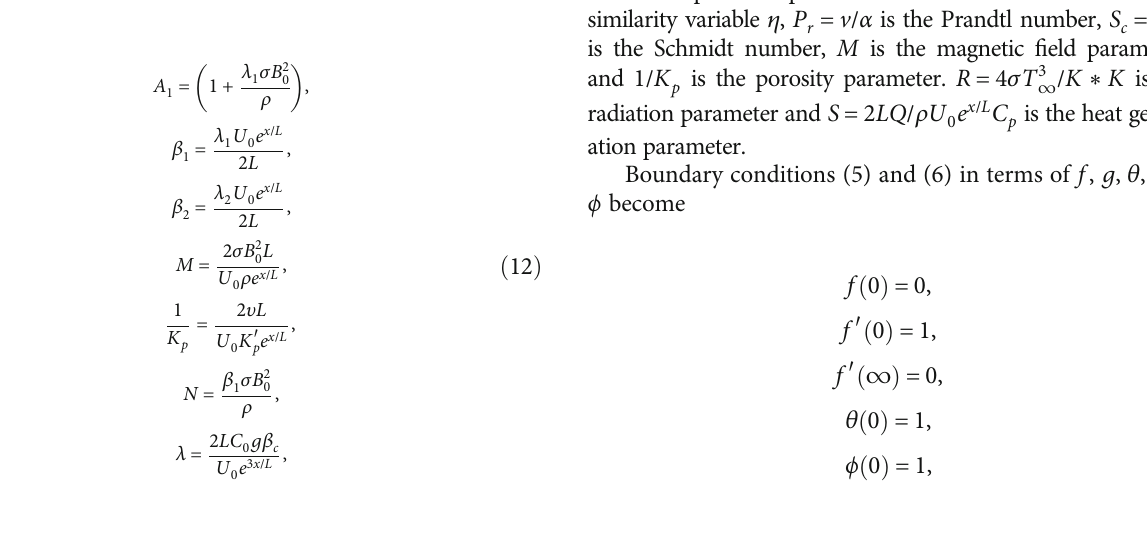
Figure 4: (a) Di ff erent values of thermal radiation R on the temperature pro fi le. (b) Di ff erent values of Prandtl number P temperature pro fi